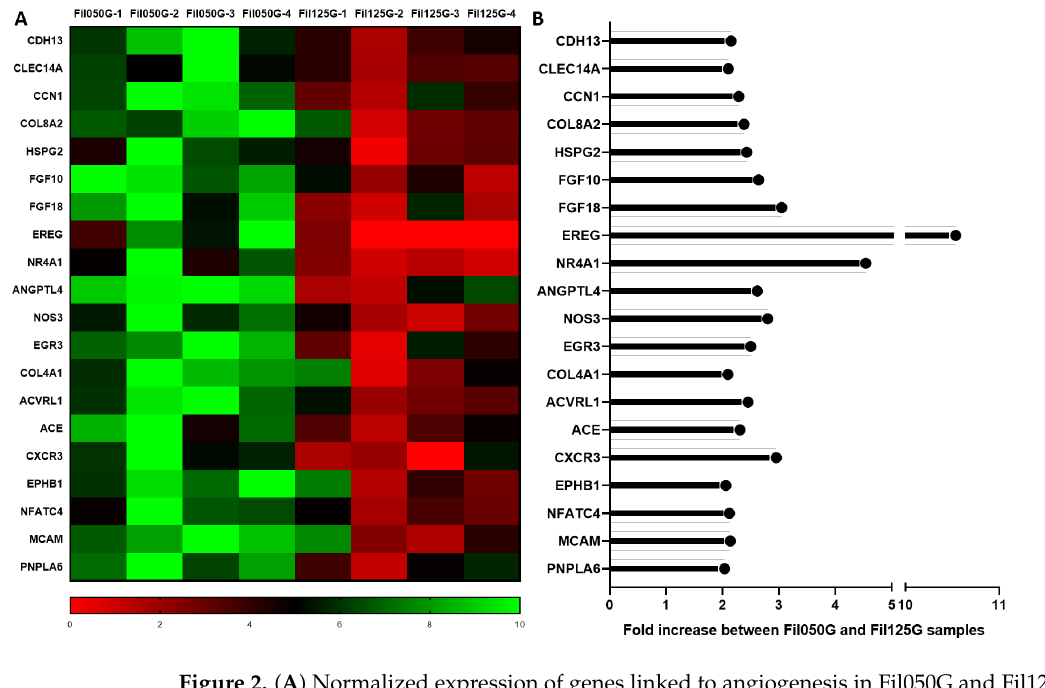
Figure 2. ( A ) Normalized expression of genes linked to angiogenesis in Fil050G and Fil125G samples ( n = 4, each). ( B ) Fold increase of genes linked to angiogenesis in Fil050G and Fil125G samples.